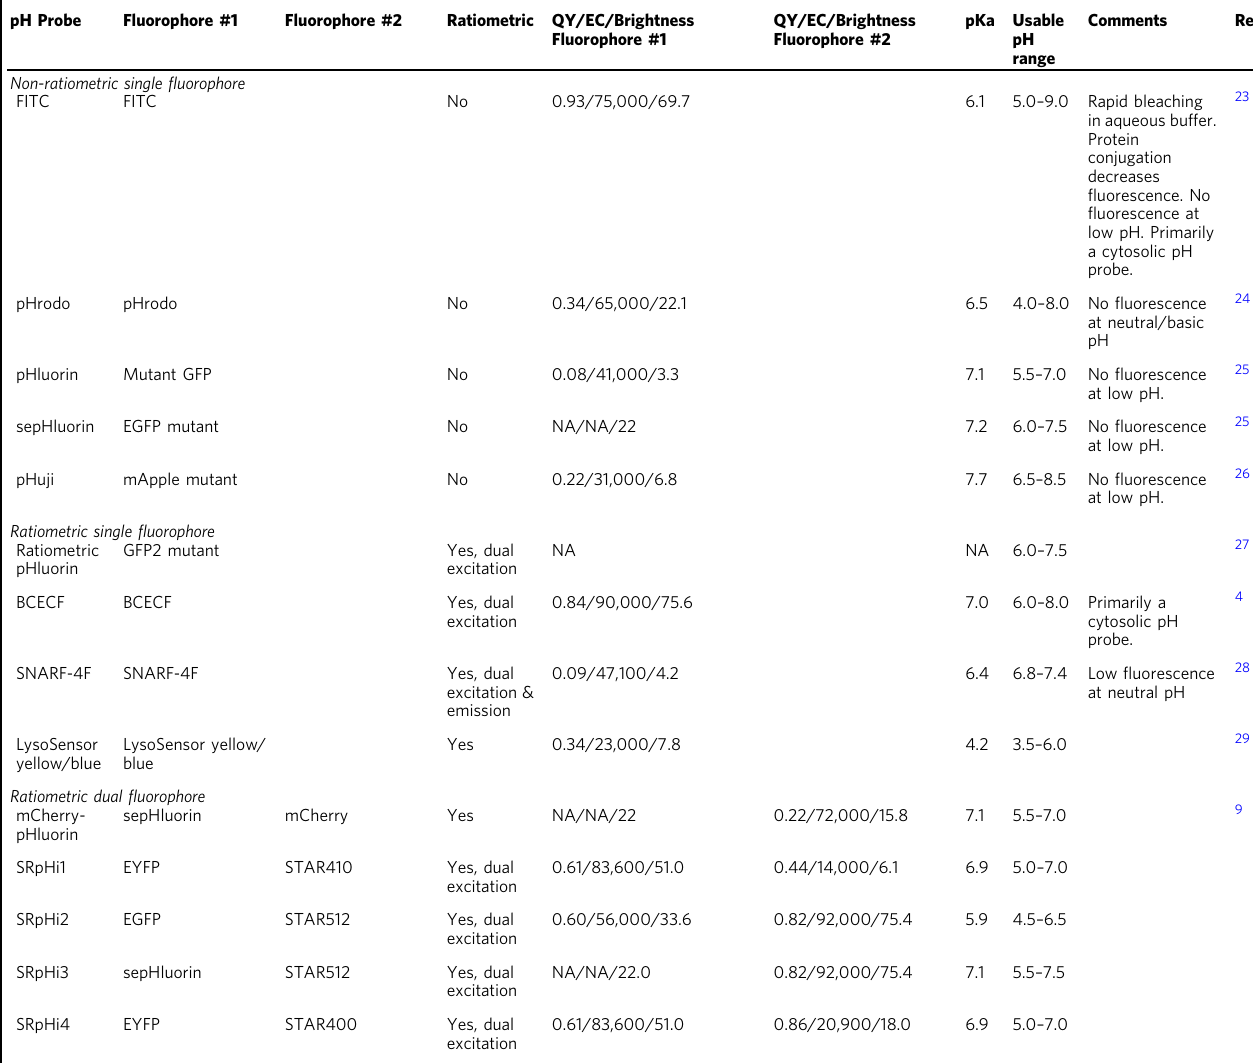
Table 1 Properties of biological pH sensors pH Probe Fluorophore